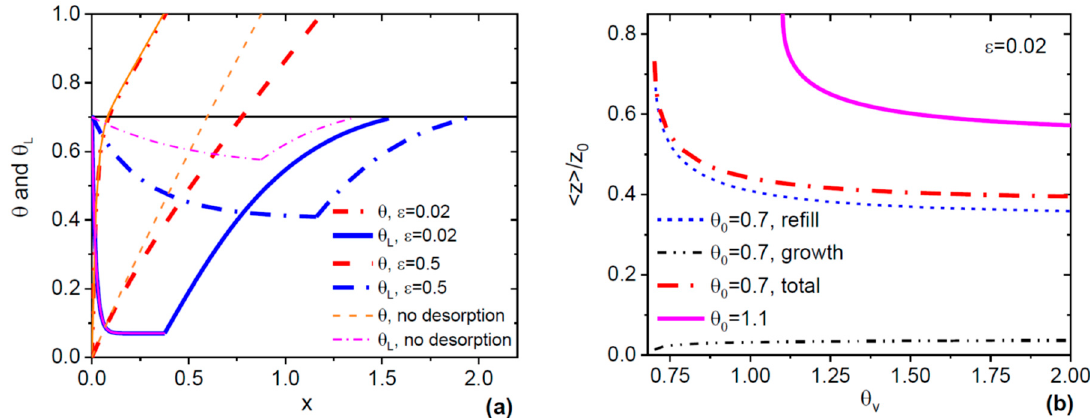
Figure 3. ( a ) One oscillation of the monolayer (ML) coverage and As content in liquid a ff ected by As desorption, at θ eq = 0.05, θ 0 = 0.7, θ v = 0.75, and two di ff erent ε = 0.02 (bold solid lines) and 0.5 (bold dashed lines). Thin lines show the corresponding behavior which would be observed without As desorption in the ML growth stage. At small ε , the growth stage is not a ff ected by desorption, while the refill stage is prolongated. The As content drops very sharply as the ML grows. At large ε , the ML growth stage is much longer than without desorption and contributes to the total prolongation of the ML formation cycle. The As concentration varies much less than at small ε , as we saw earlier in Figure 1b. ( b ) Normalized electron-to-hole ratio in Si-doped GaAs NWs in systems with As desorption at a fixed ε = 0.02 versus θ v , at two di ff erent θ 0 = 0.7 and 1.1 (bold lines). At θ 0 = 0.7, the dash-dotted and short-dashed lines show the contributions of the ML growth and refill stages into the resulting ratio (cid:104) z (cid:105) / z 0 . The contribution of refill is dominant for these parameters. At θ 0 = 1.1, the ML growth is instantaneous, and the decrease of the electron-to-hole ratio is only due to refill. Overall, a smaller θ 0 yields a stronger suppression of n-type Si doping. The ratio (cid:104) z (cid:105) / z 0 monotonically decreases with increasing θ v , meaning that higher As desorption rates lead to larger electron-to-hole ratios.